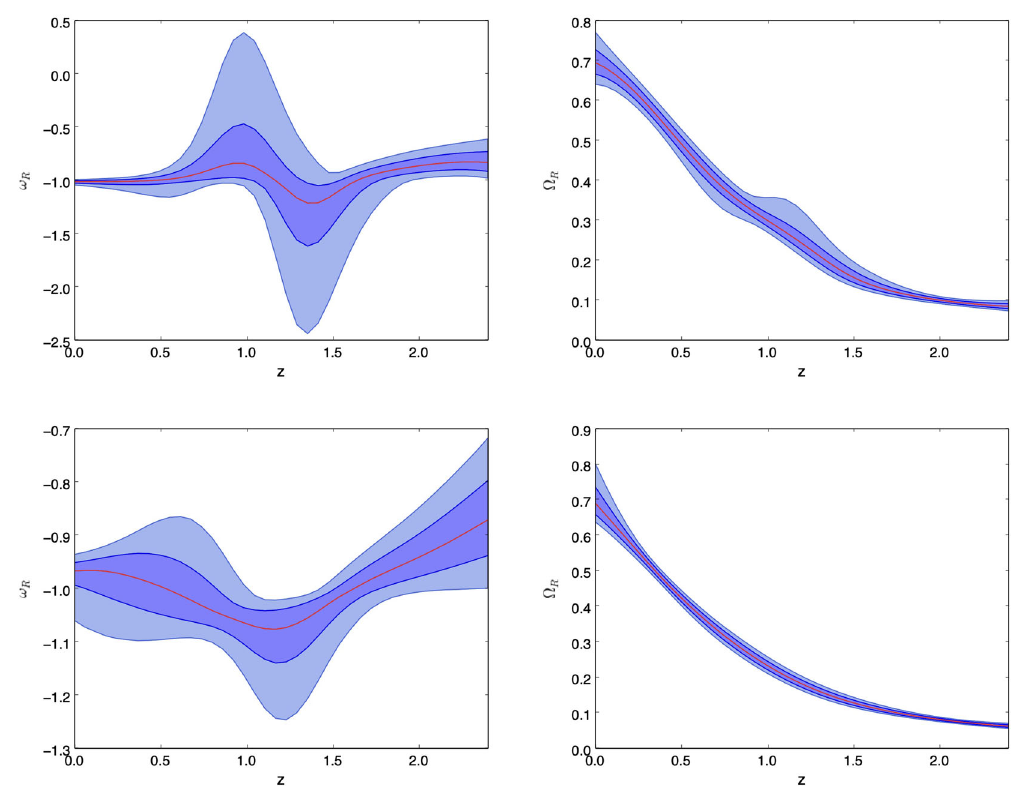
Fig. 9 The GP reconstruction of ω R and (cid:13) R for the 30 H ( z ) samples deduced from the differential age method with 10 additional samples obtainedfromtheradialBAOmethod(Table1)ispresentedontheupper panel, when H 0 = 73 . 52 ± 1 . 62 km s − 1 Mpc − 1 has been merged to the expansion rate data used in the GP. The bottom panel represents the GP reconstruction of ω R and (cid:13) R , when H 0 = 67 . 40 ± 0 . 5 km s − 1 Mpc − 1 has been merged to the expansion rate data used in the GP. The obtained reconstruction is for the f ( R ) model given by Eq. (24). The solid line